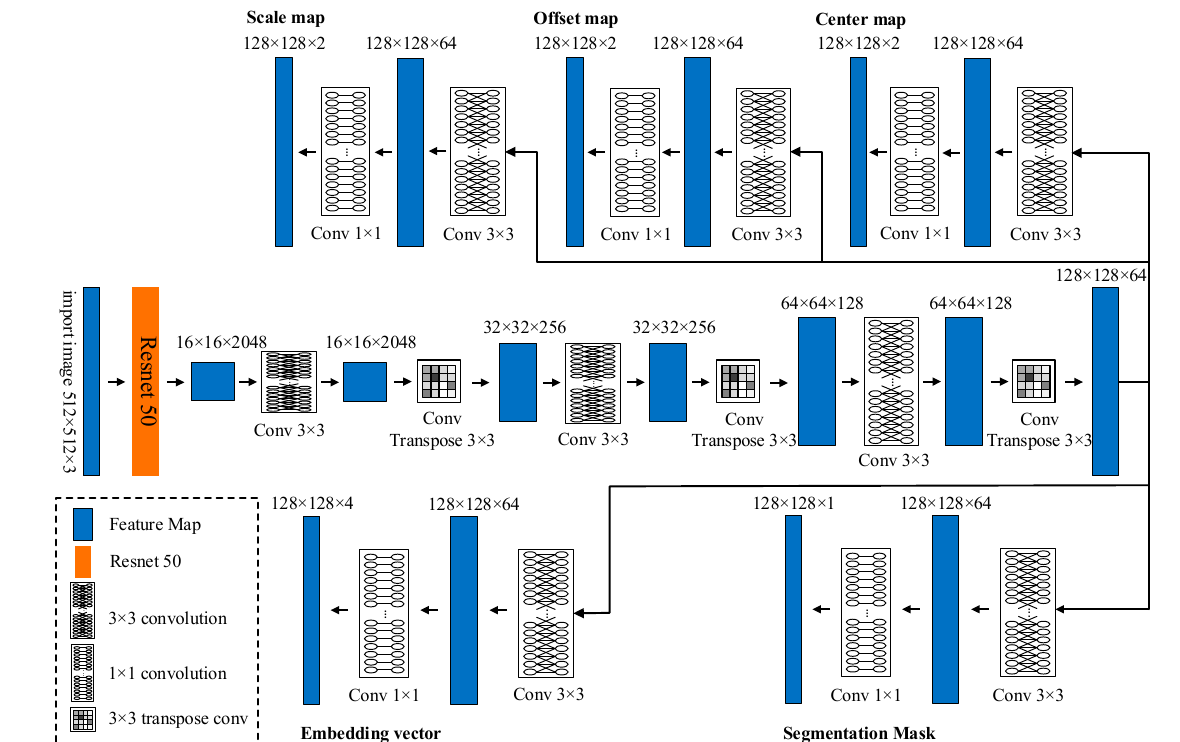
Figure 2. Model architecture diagram.